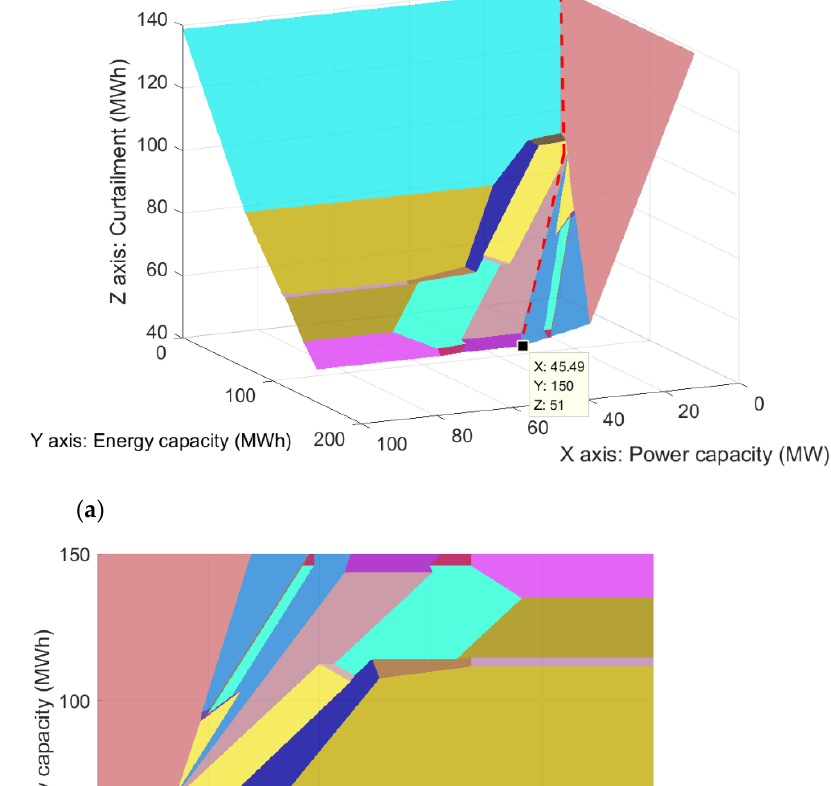
Figure 7. Comparison of optimal value functions with different values of 𝜀 .